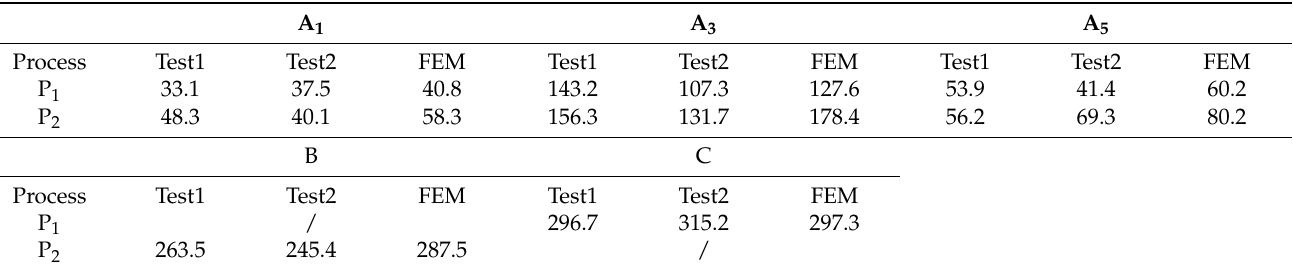
Table 3. Soil stress results of pile group tests (Unit: